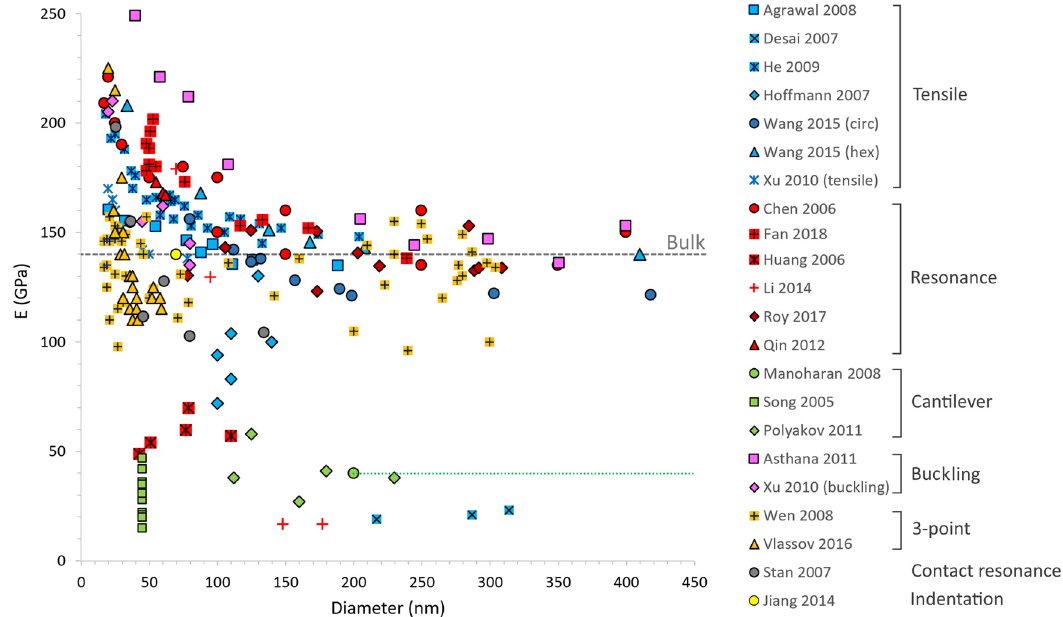
Figure 6: Summary of Young ’ s modulus of ZnO nanowires reported by di ff erent authors. Di ff erent colors represent di ff erent methods: blue – tensile, red – resonance method, green – cantilevered, orange – three - point bending, yellow – indentation, purple – buckling and grey – contact resonance